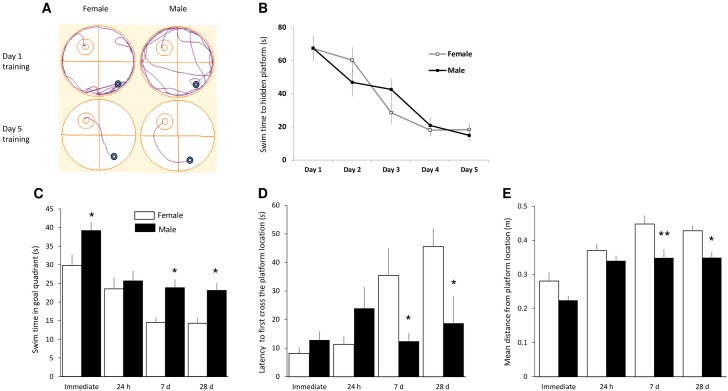
Male rats show better retention of spatial learning in the Morris Water Maze.(A) Representative swim paths show dramatic improvement for both male and female animals from Day 1 (naïve) to Day 5 of training. (B) Mean latencies to find the hidden platform over the 5-day training period. There was no significant difference in the learning curves for male and female animals. (C) Swim times in the goal quadrant during probe trials show that both male and female rats focused their search in the region of the platform’s location during the probe trial given immediately after training. However, males spent more time in the goal quadrant in probe trials given 7d and 28d after training. (D) Time to first cross the platform location during successive probe trials. Times were equivalent for the immediate and 24 h probes, but male rats outperformed females (shorter time to swim to the platform location) 7 d and 28 d after training. (E) Mean distance of the swim path from the platform location, showing shorter mean distance for male rats. n = 6 rats for each sex, *p < 0.05, ** p < 0.01, compared to males.